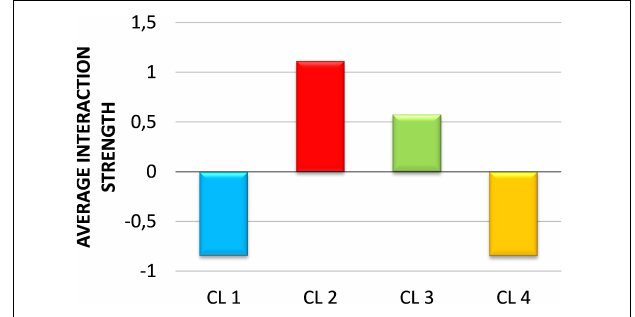
FIGURE 8 | The average strength of all trophic interactions within the microbial food web in the four clusters. Values are standardized as